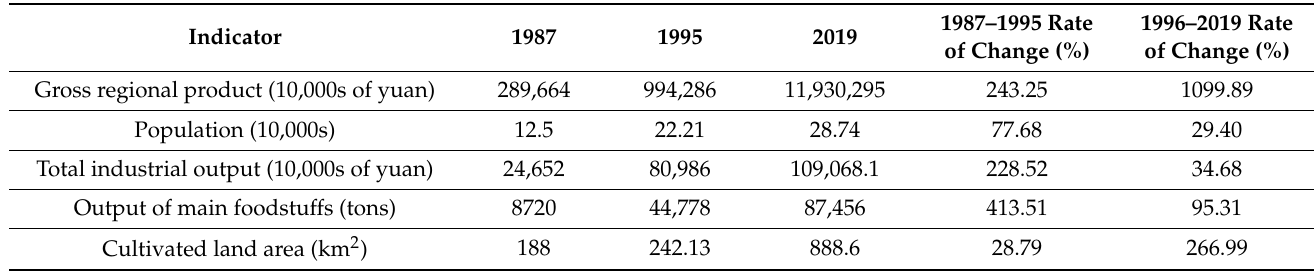
Table 8. Social and economic indicators reflecting human activity in the Hailar River area in 1987, 1995, and 2019.